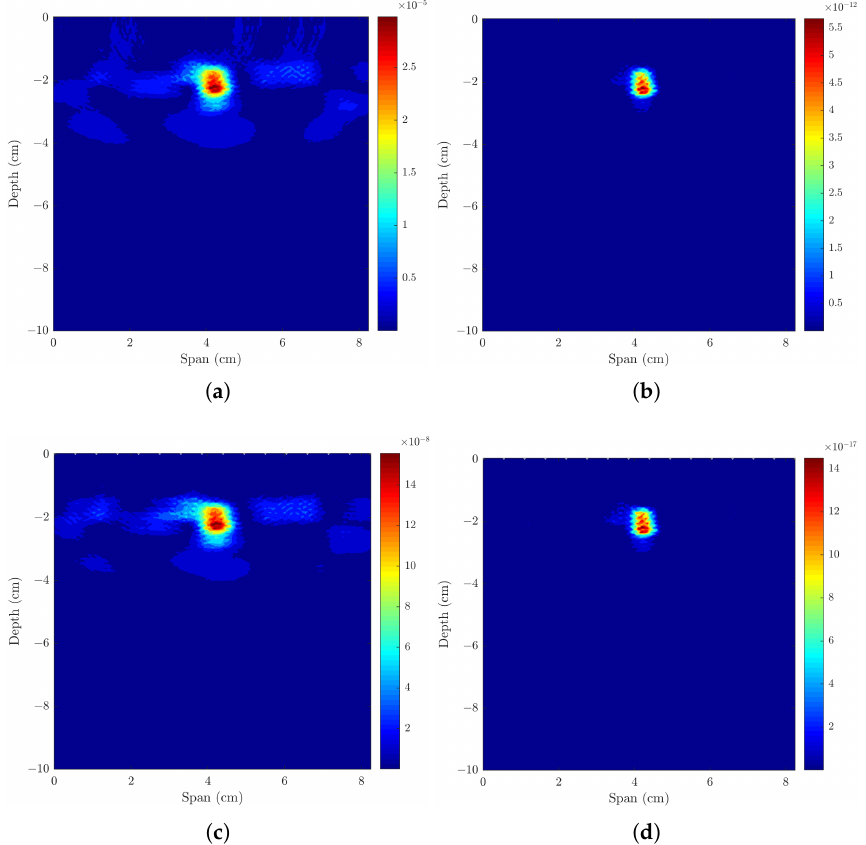
Figure 4. Backscattered energy results from the implemented MWI system of an axillary region model with a sinusoidal skin layer using four different beamformers—( a ) DAS, ( b ) DMAS, ( c ) CR-DAS and ( d ) CR-DMAS—after applying Bond’s artifact removal algorithm. The high intensity regions indicate the detection of the lymph node.